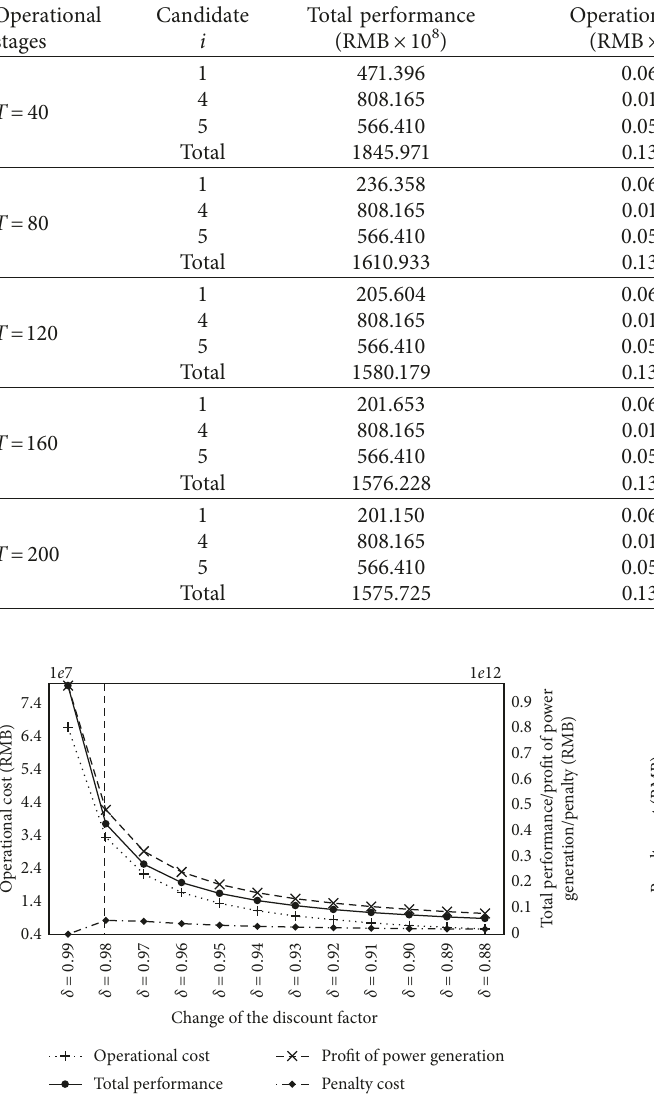
Figure 11: Penalty cost under the different discount factors